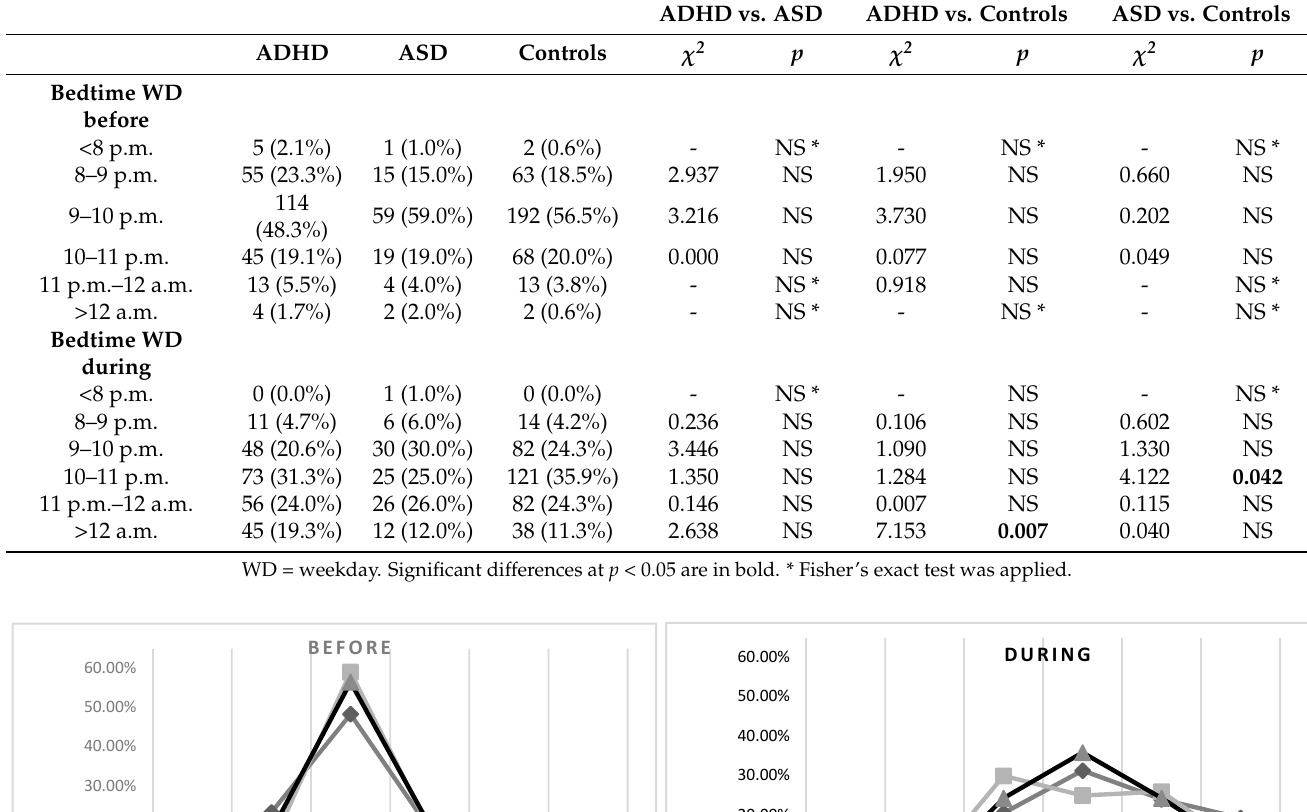
Table 2. Comparison between bedtime in weekdays before and during lockdown in the three groups. ADHD vs. ASD ADHD vs. Controls ASD vs. Controls